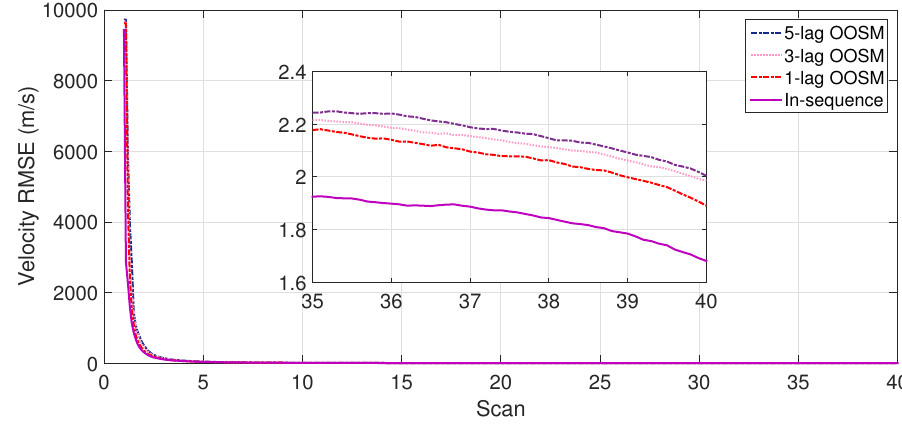
Figure 8. RMSE in velocity estimate for the B l 1